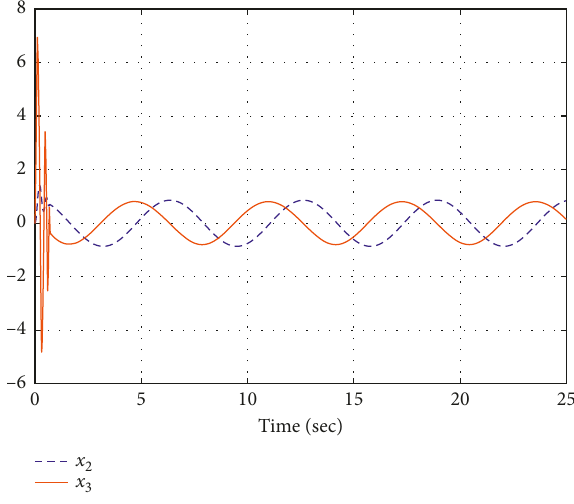
Figure 2: Evolution of state x